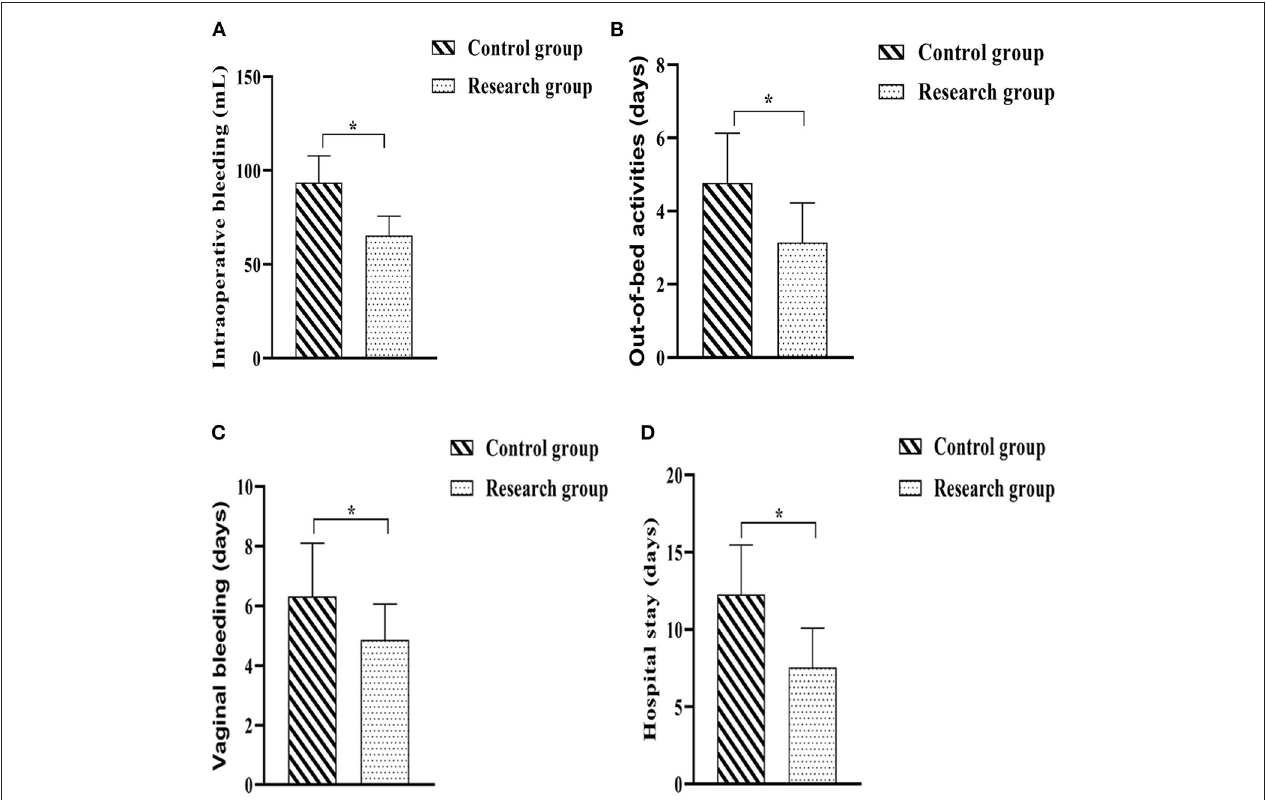
FIGURE 2 | Comparison of surgery-related indicators between the two groups. (A) Intraoperative bleeding; (B) Out-of-bed activities; (C) Time of vaginal bleeding; (D) Hospital stay. Comparison between the two groups, * P < 0.05.